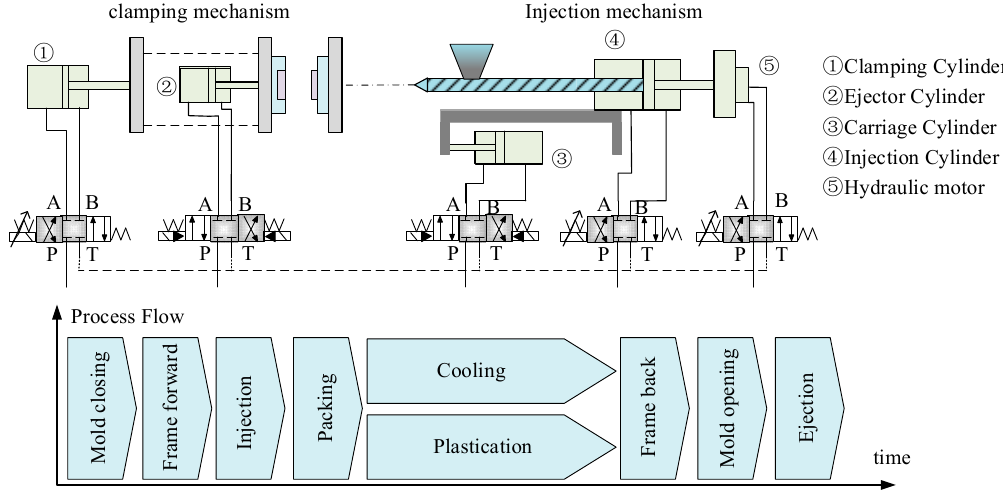
Figure 2. The composition, appearance, and process of a hydraulic injection-molding machine (IMM).